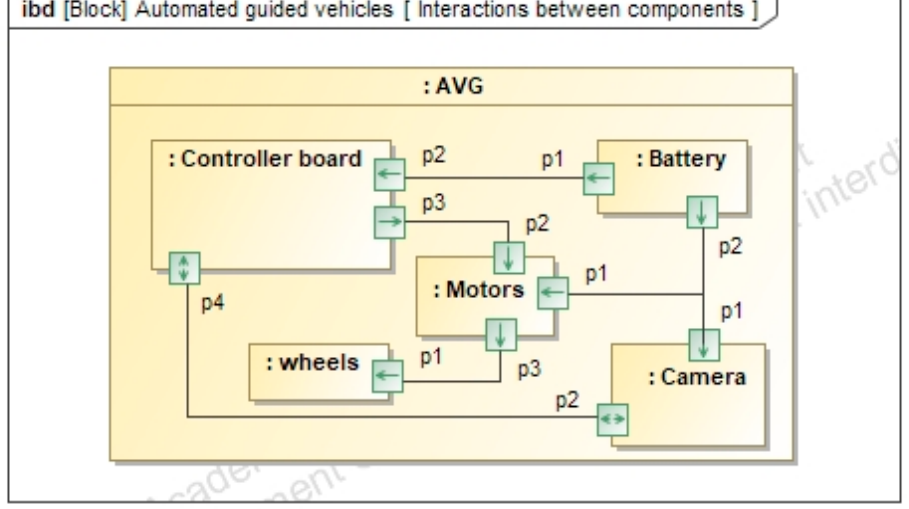
Figure 17. Interaction between system components in SysML. Figure 18 shows the 3D structure of the AGV according to the model developed with the IBD and BDD diagrams. The width and length are 0.45 m and 1 m respectively and the height is 0.3 m. This AGV structure is made of four wheels and four motors. Each wheel is driven by a servo-motor with an assembled gearbox and each AGV contains an autonomous